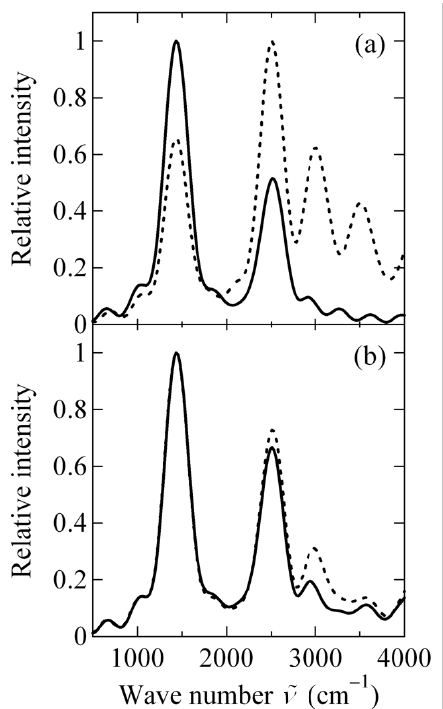
Figure 7. The frequency spectra of ψ X ( Q , t ), σ X ( ω ), defined by Equation (34) for DCP irradiated by ( a ) linearly and ( b ) circularly polarized VUV laser pulses. In panel ( a ), the spectra for e (+) and e (−) are denoted by the solid and dotted lines, respectively; in panel ( b ), those for e +1 and e −1 are denoted by the solid and dotted lines, respectively. In each case, the values of σ X ( ω ) were scaled so that the maximum value is unity. Reprinted from [56] with permission of the American Chemical Society.